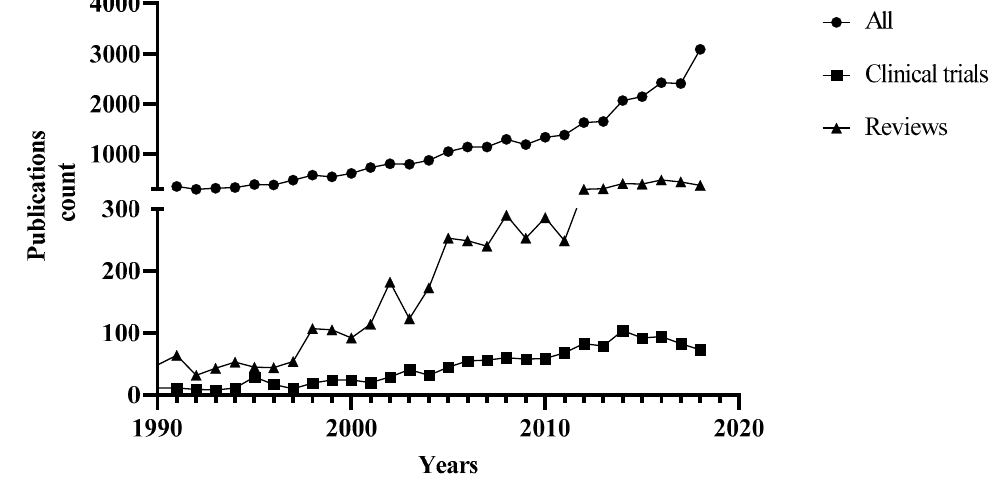
Figure 1. The PubMed retrieved publications (1990–2018) for studies on medicinal cannabis/marijuana/cannabinoids/tetrahydrocannabinol/cannabidiol.